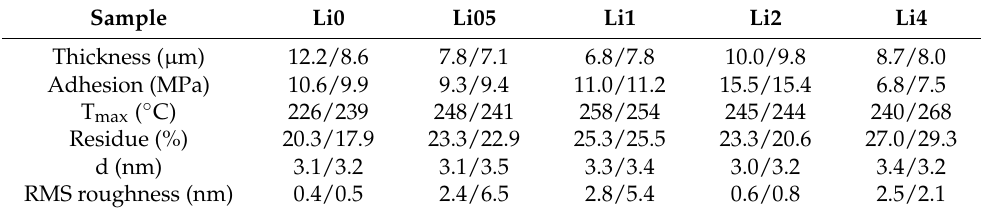
Table 1. Properties of PMMA–silica–Li hybrids: thickness of the films obtained by optical interferom- etry, adhesion to the substrate determined by the Pull-off test, thermal stability (T m á x ) and residue extracted from TGA, correlation distance (d) between the silica nodes determined by SAXS, and RMS roughness values extracted from AFM images. All quantities were obtained in